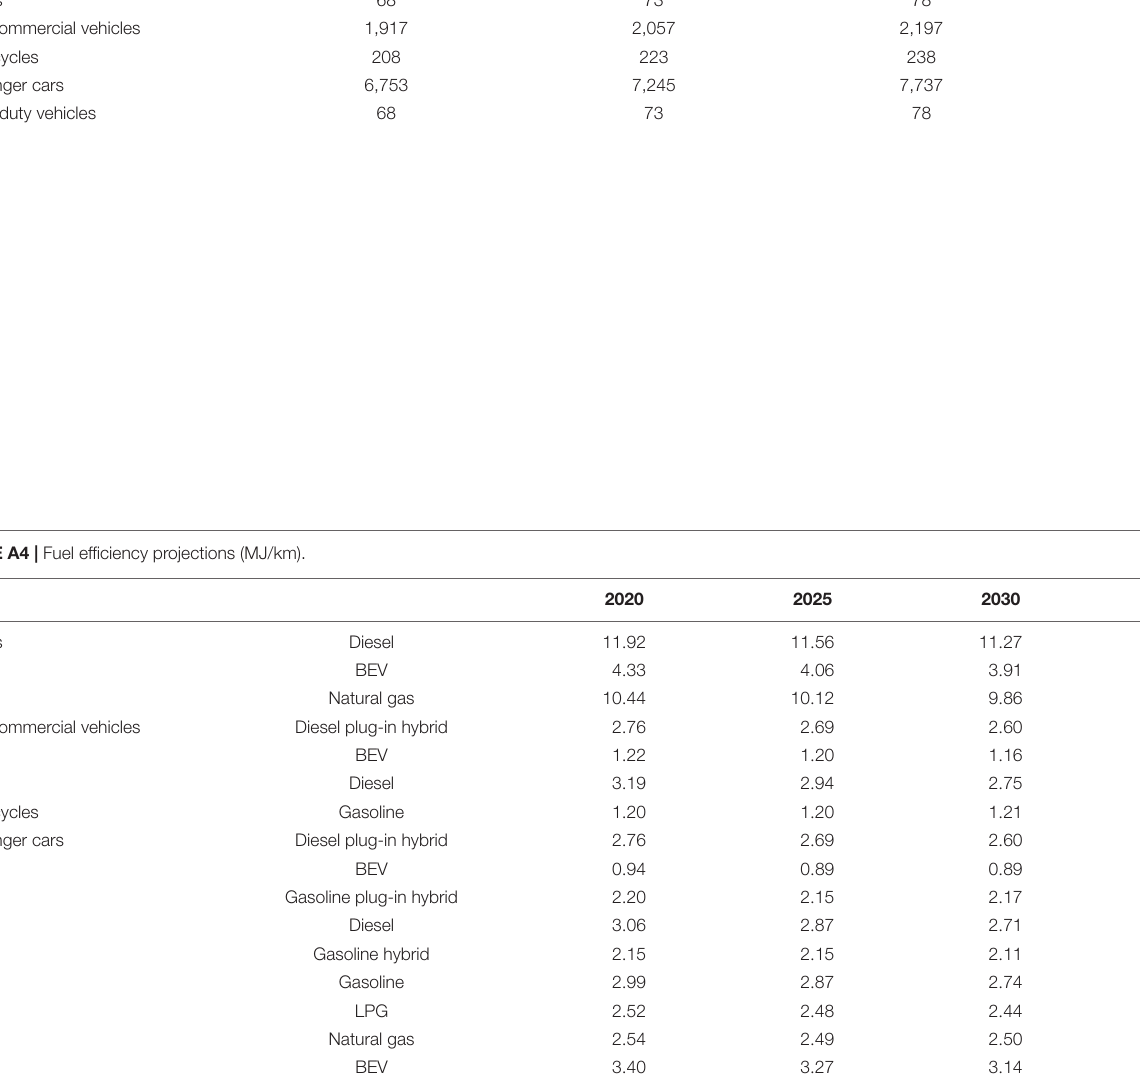
TABLE A3 | Total mileage projection for each mode of transport. Million veh-km